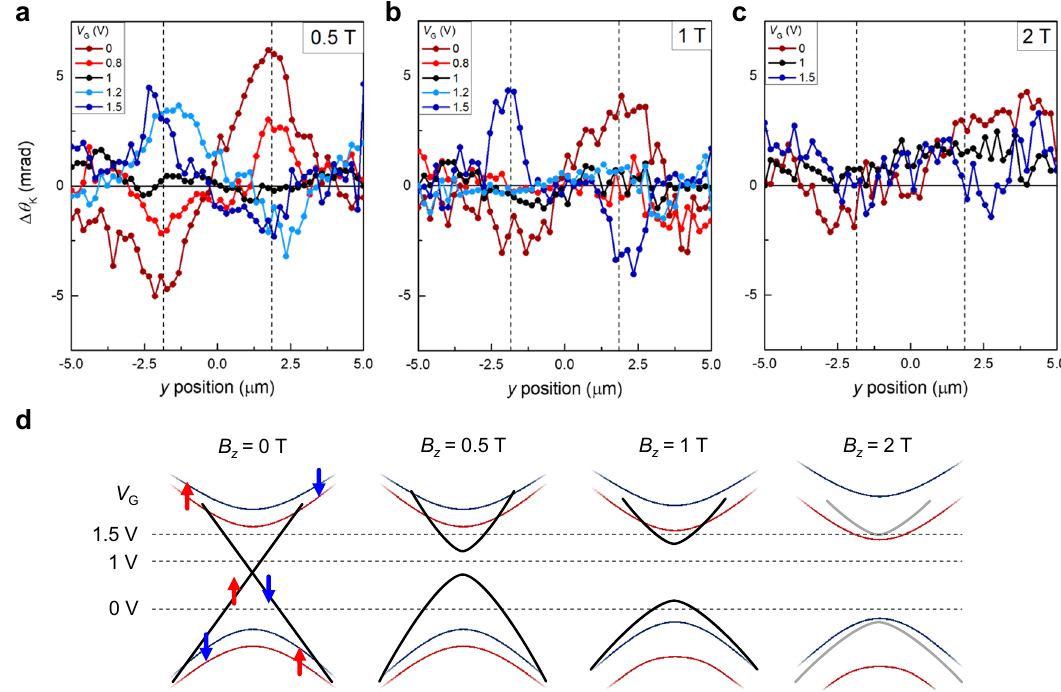
Fig. 3 | Gap opening of the multilayer WTe2 due to broken time-reversal sym- breaks the time-reversal symmetry, Dirac fermions at the topological hinge states metry. a – c The line-cut plots show Δ θ K at x =0.75 μ m with varying V G under gain an effective mass. This opens a fi nite energy gap, which is proportional to the V B z =0.5T, B z =0.5T ( a ), 1T ( b ), and 2T ( c ). Δ θ magnitudeof B z .Thegapopeningappearsasa fl at Δ θ K along y sincetheFermilevel K is featureless only at G =1V when while it shows no variation when the applied V G is 0.8V ≤ V G ≤ 1.2V under B z =1T. falls within thegap.The dashed lines inthediagram indicate the Fermilevelswhen V B z =2T ( d ), the schematic represents one Note thatno localized Δ θ K behavior isseenatany V G when B z =2T.Dashed lines in G is 0, 1, and 1.5V. For the case when a – c at y =±1.85 μ m indicate the y position of the WTe 2 hinges in the real space. possibility that the hinge states are merged into the bulk band due to the induced d , Schematic band structures representing the effect of B z on the spin-polarized gap in the hinge hinge states (black lines) and spin-split bulk bands (colored lines). Because B z